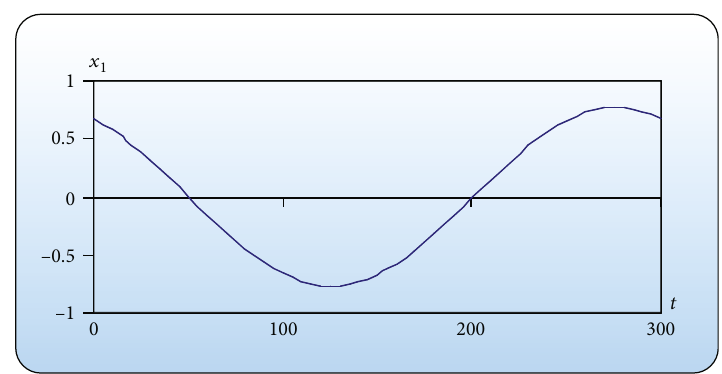
Figure 1: The analytical solution x